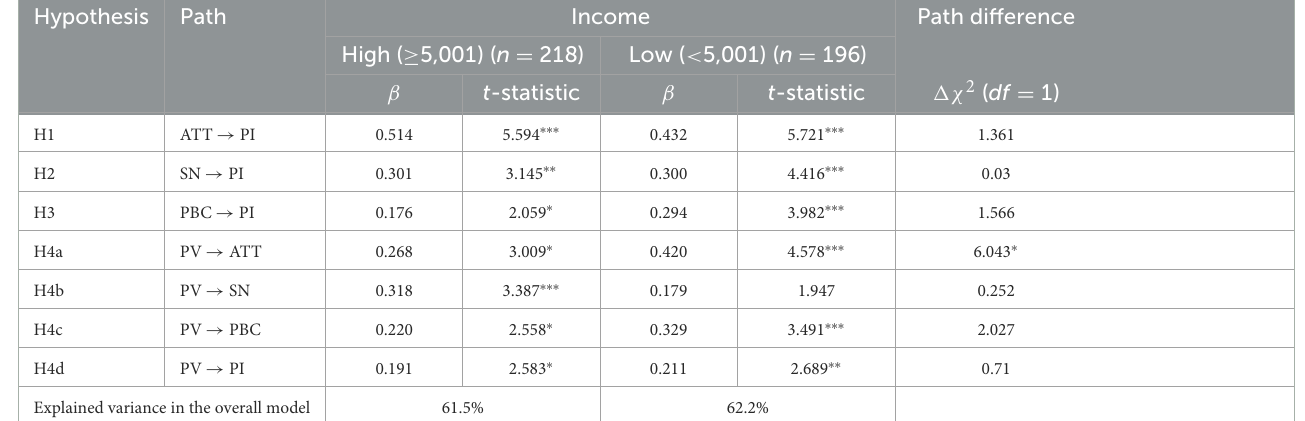
TABLE 7 Path coefficients comparison of MGA by income.